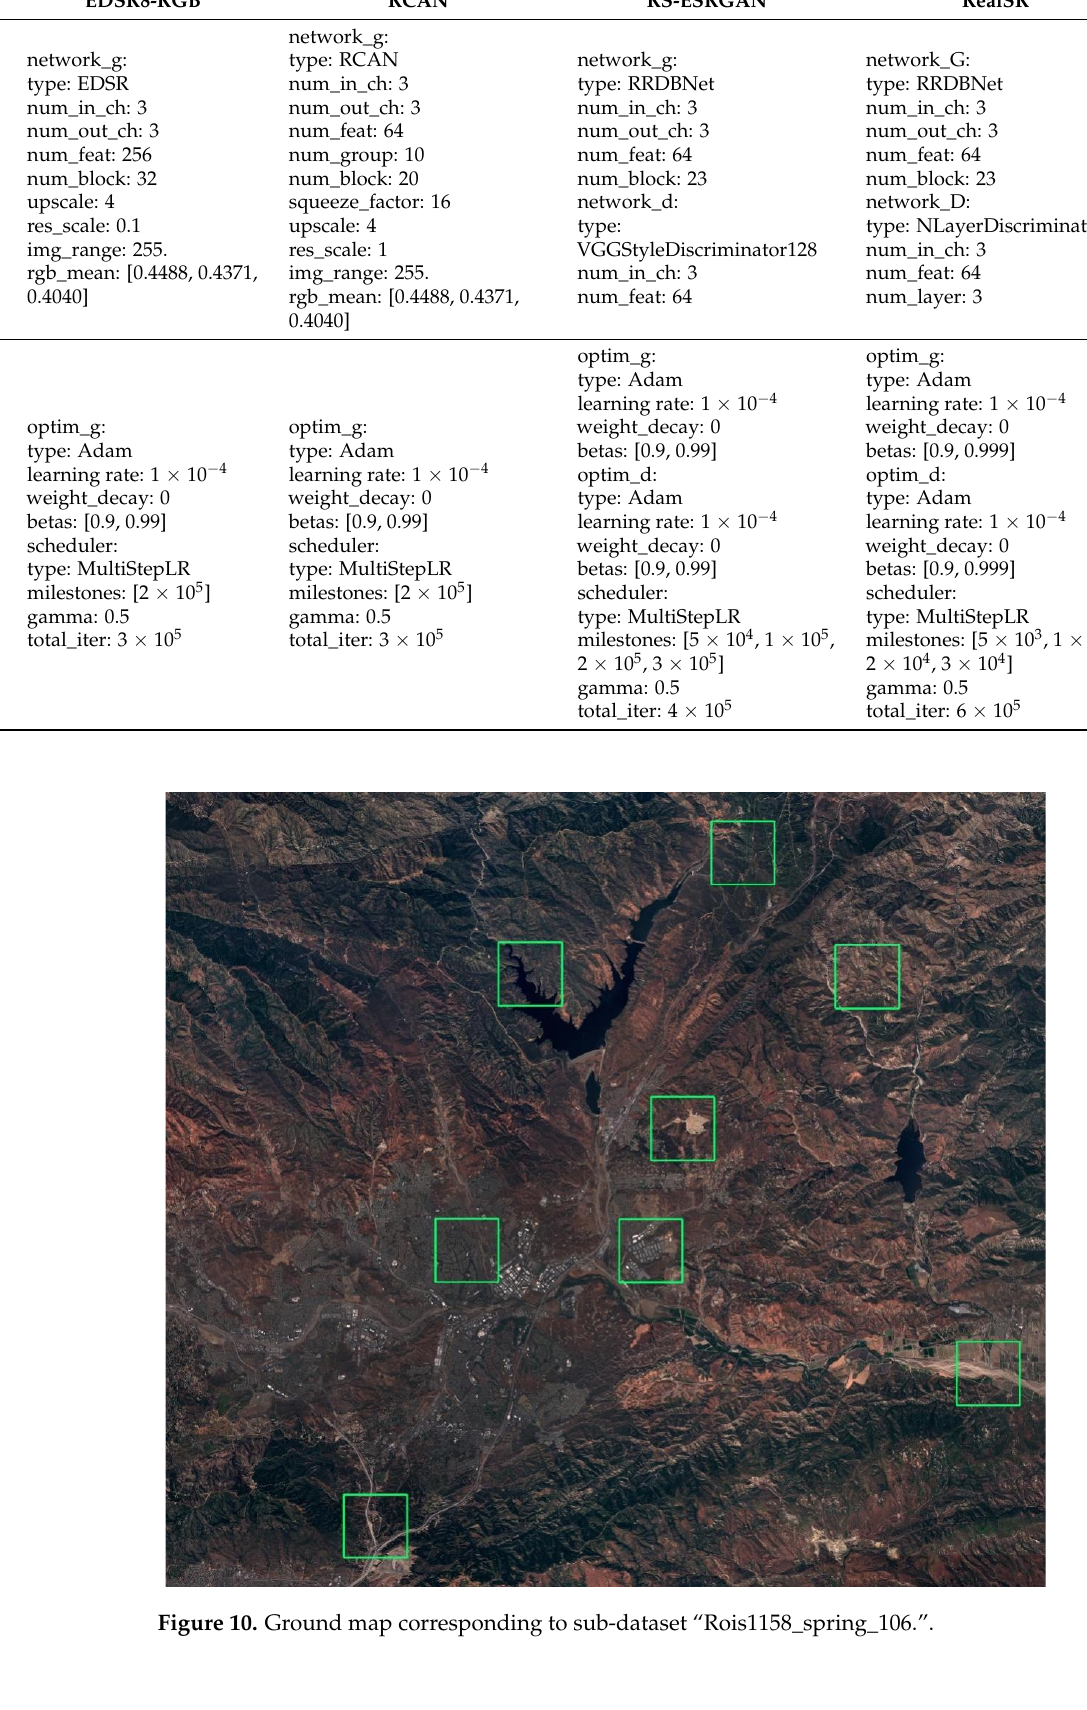
Figure 11. Distribution of evaluation values of NR-IQA metric NIQE.